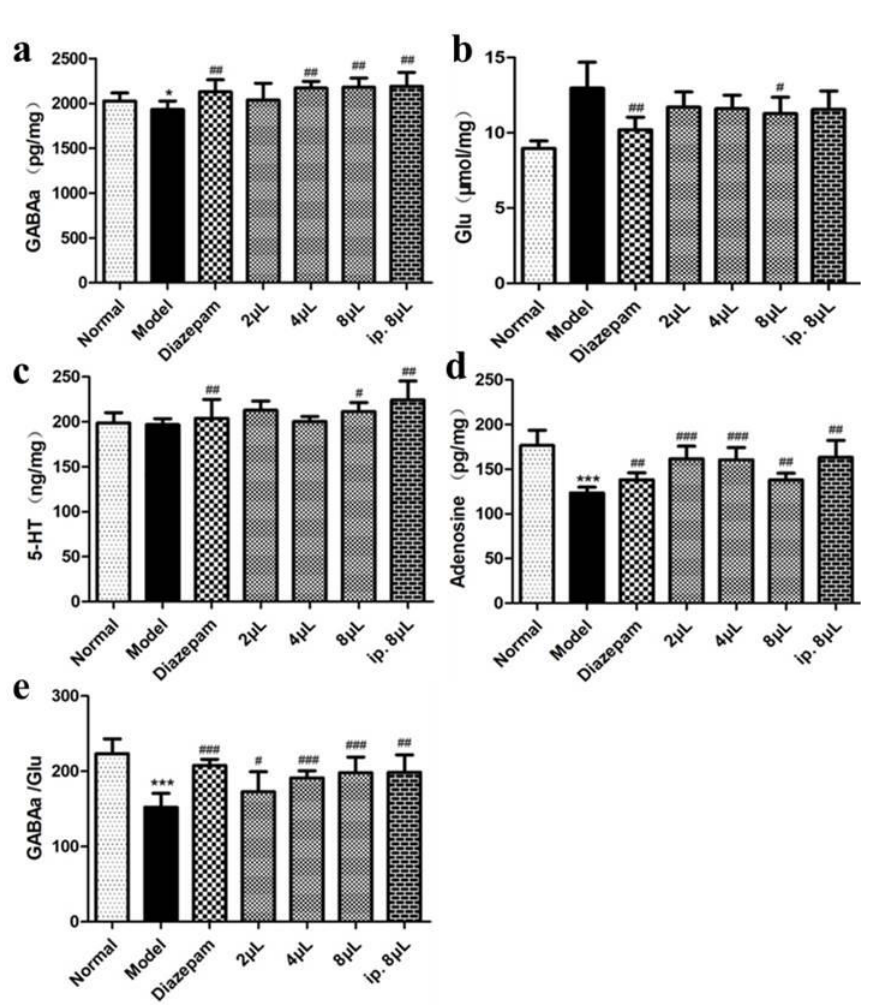
Figure 3. Effects on the level of neurotransmitters of AEO inhalation. ( a ) GABAa, ( b ) Glu, ( c ) 5-HT, ( d ) adenosine, ( e ) GABAa/Glu. All values are expressed as the means ± SD ( n = 8). * p < 0.05, *** p < 0.001 vs. normal group; # p < 0.05, ## p < 0.01, ### p < 0.001 vs. model group.